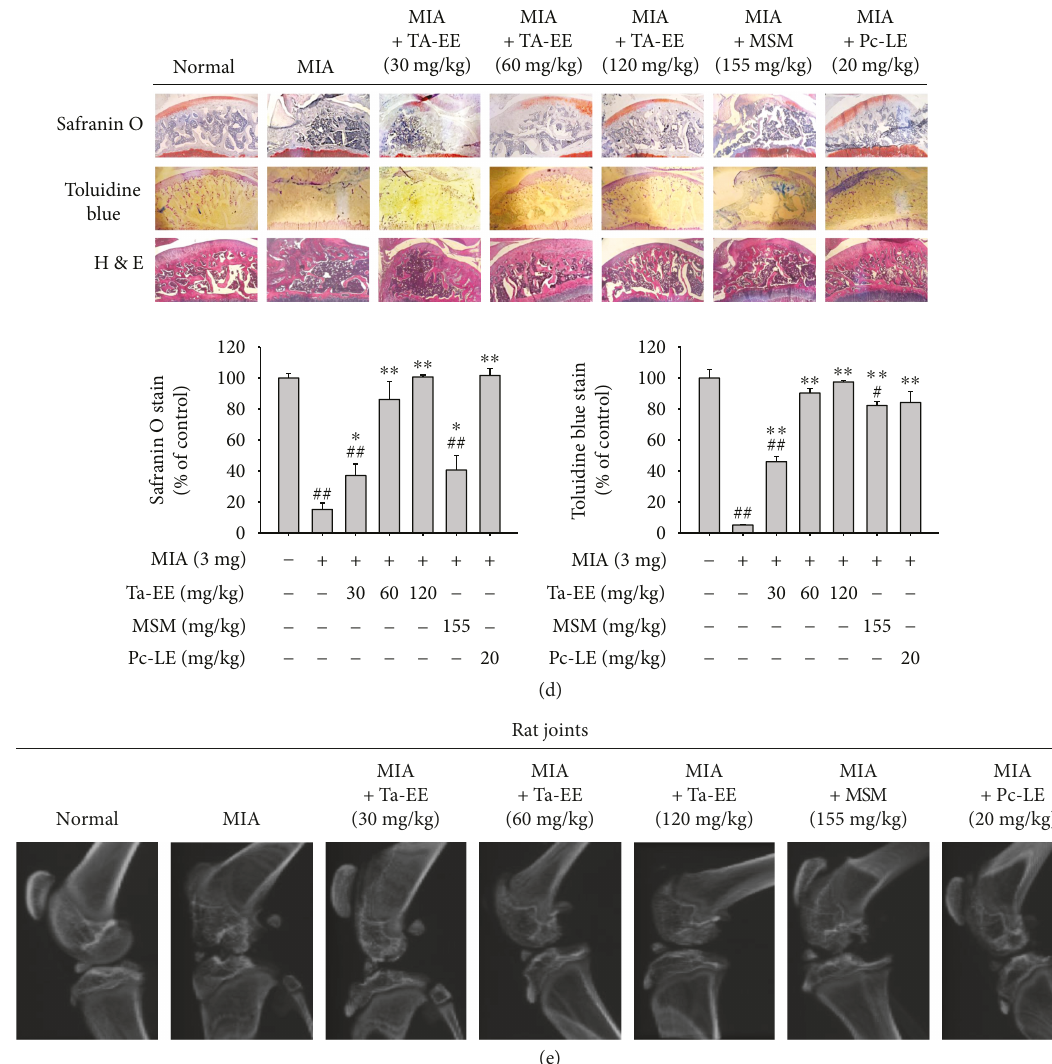
Figure 1: Ta-EE ameliorated OA symptoms in MIA-induced OA rats. (a) Experimental schedule of OA induction, treatment, and evaluation. Sprague-Dawley rats (10 rats/group) were intra-articularly injected with MIA (3 mg/rat). One week later, the rats were subjected to di ff erent treatments once a day for four weeks. The study fi nished at week fi ve. (b) MIA-induced OA rats were orally administered with either Ta-EE (30 – 120 mg/kg), MSM (155mg/kg), or Pc-LE (20 mg/kg) once a day for four weeks, and paw withdrawal threshold was measured once a week for fi ve weeks. The signi fi cance of each group with respect to the MIA group each week is summarized in the box. (c) Body weights of the rats were measured once a week for fi ve weeks. ((d); left panel) MIA-induced OA rats were orally administered with Ta-EE (30 – 120mg/kg), MSM (155mg/kg), or Pc-LE (20 mg/kg) once a day for four weeks, and the tibia bones were stained with hematoxylin and eosin, safranin O, or toluidine blue at week fi ve. The areas stained by ((d); middle panel) safranin O and ((d); right panel) toluidine blue were measured and plotted. (e) The femur and tibia bones of the MIA-induced OA rats administered with Ta-EE (30 – 120 mg/kg), MSM (155mg/kg), or Pc-LE (20 mg/kg) were analyzed by X-ray radiography. ∗ P < 0 05 and ∗∗ P < 0 005 versus a control group; # P < 0 05 and ## P < 0 005 versus a normal